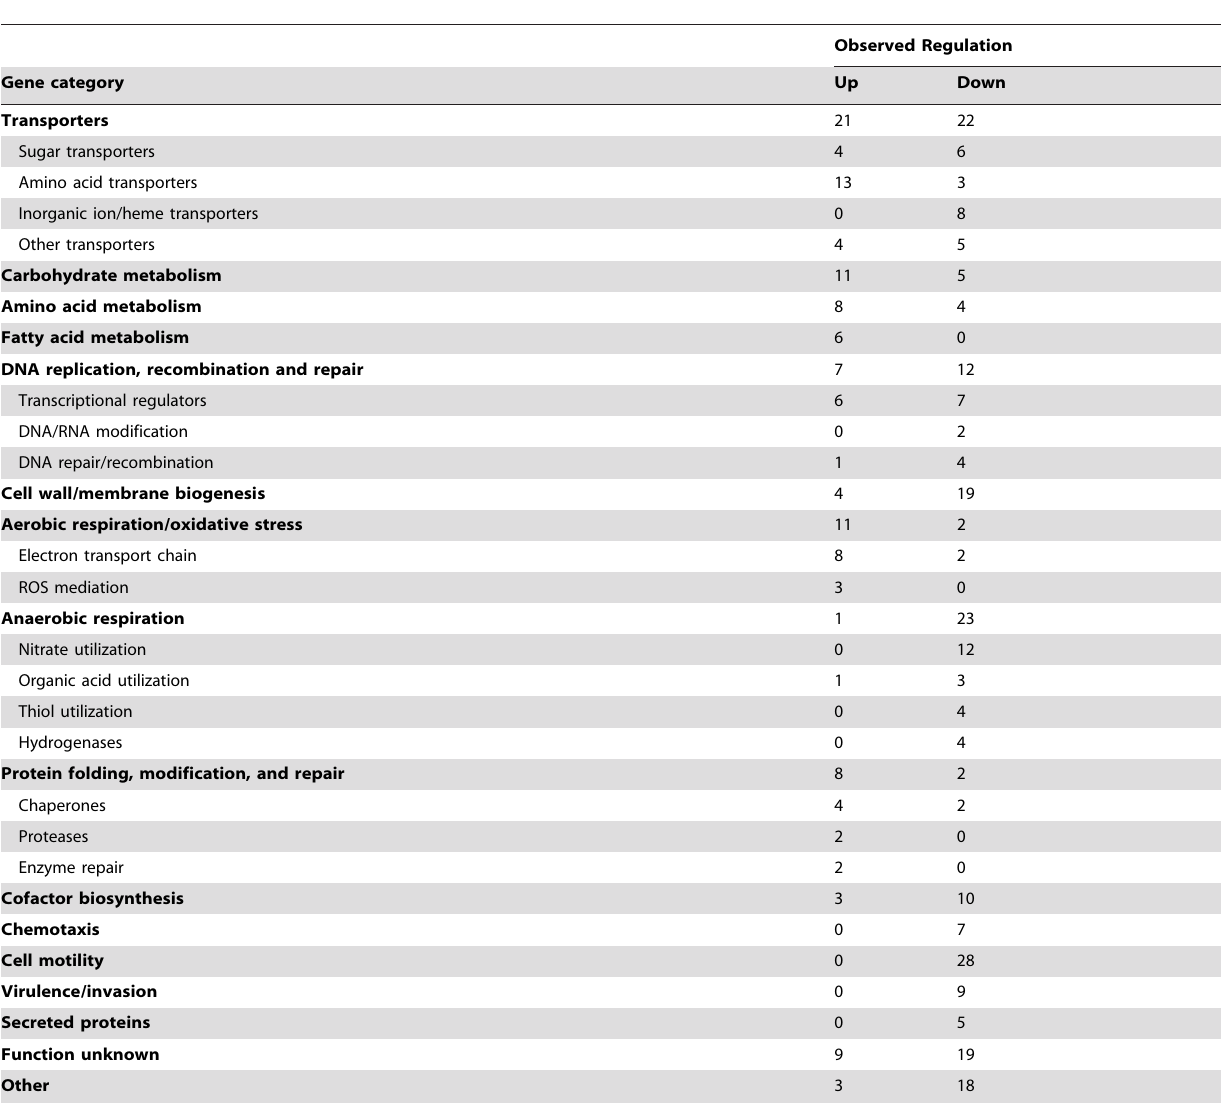
Table 1. Categories of regulated genes observed upon sub-inhibitory exposure to